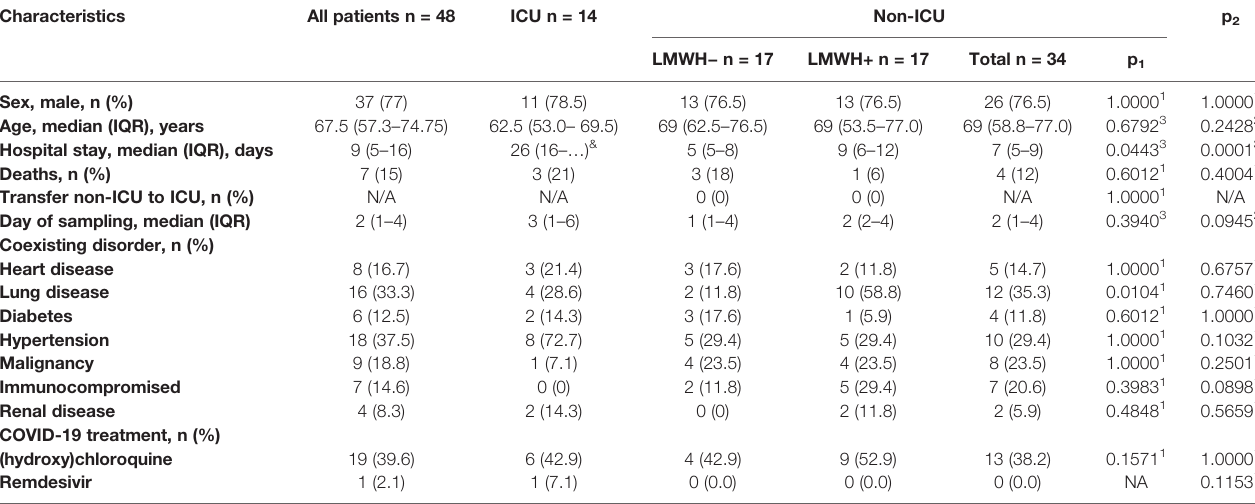
TABLE 1 | Demographics of COVID-19 patients.